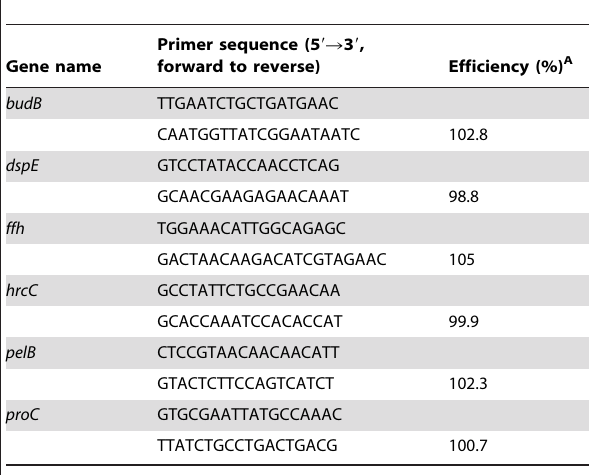
Table 2. RT-qPCR primer sequences and